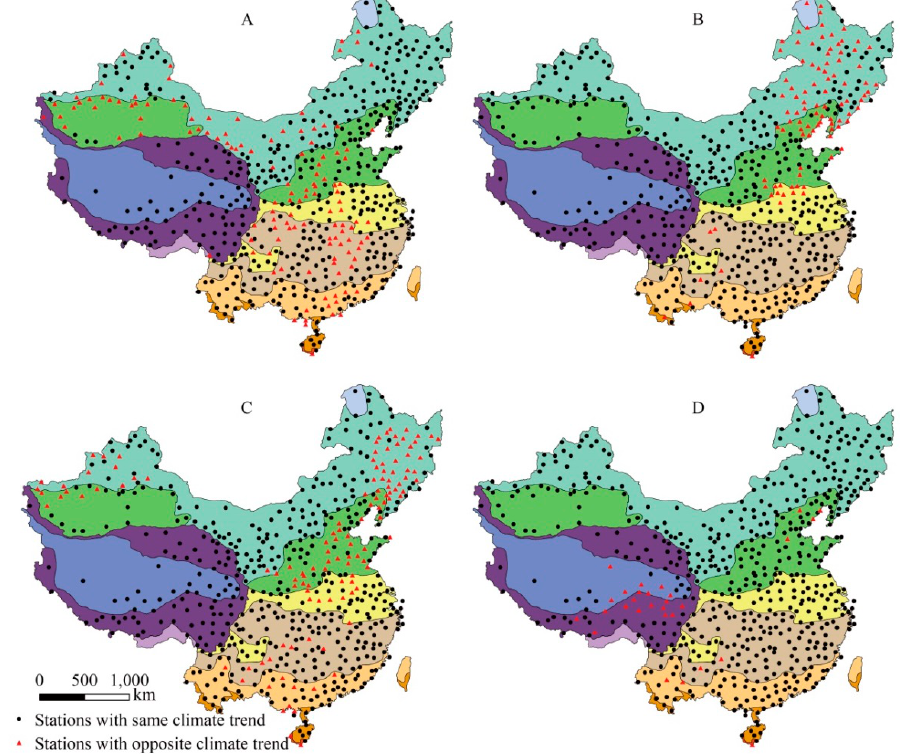
Figure 8. Climate trend of monthly maximum temperature for January ( A ), April ( B ), July ( C ) and October ( D ).